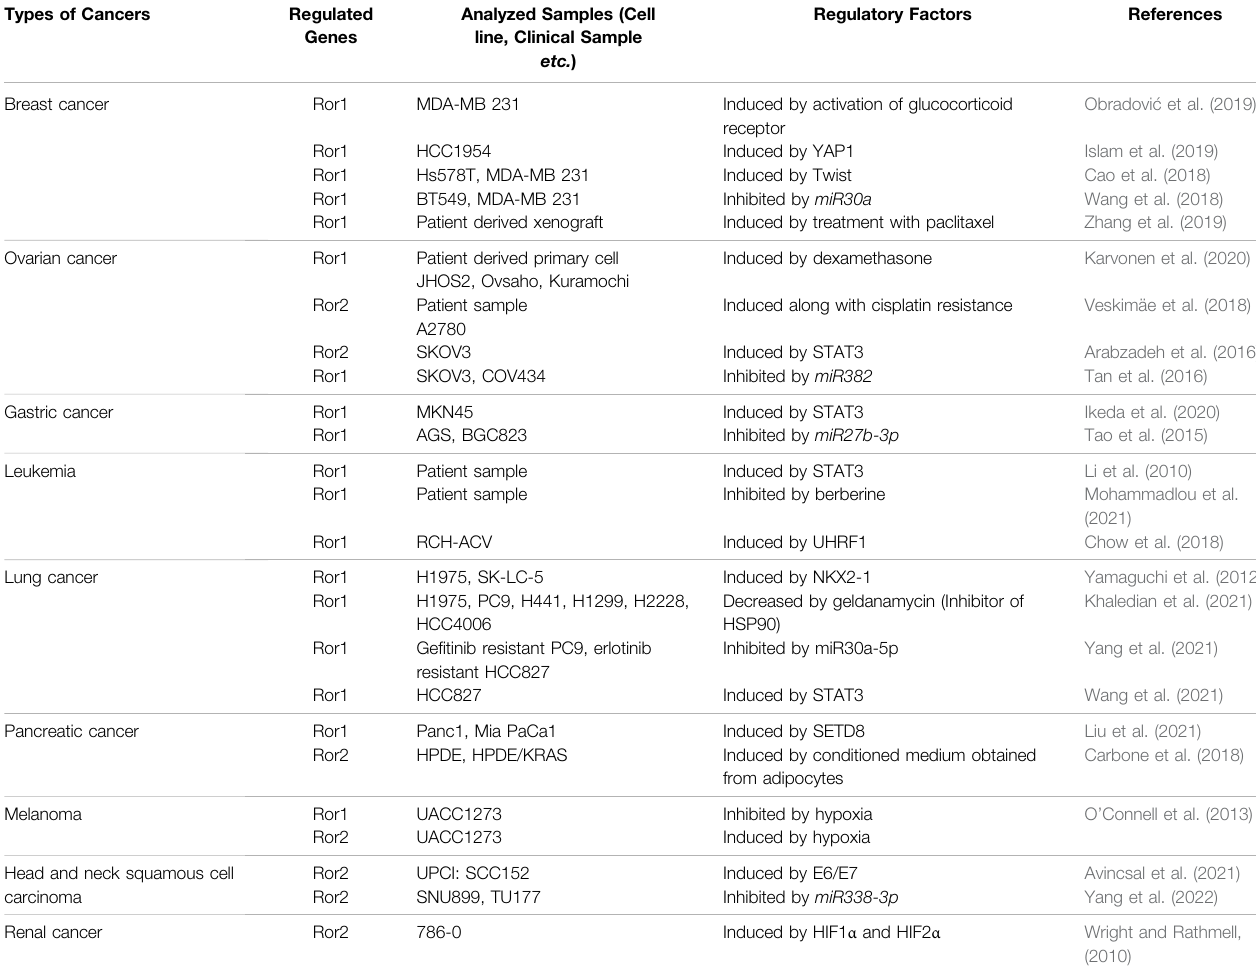
TABLE 1 | Factors and drugs regulating expression of the Ror-family receptors in cancer cells. Types of